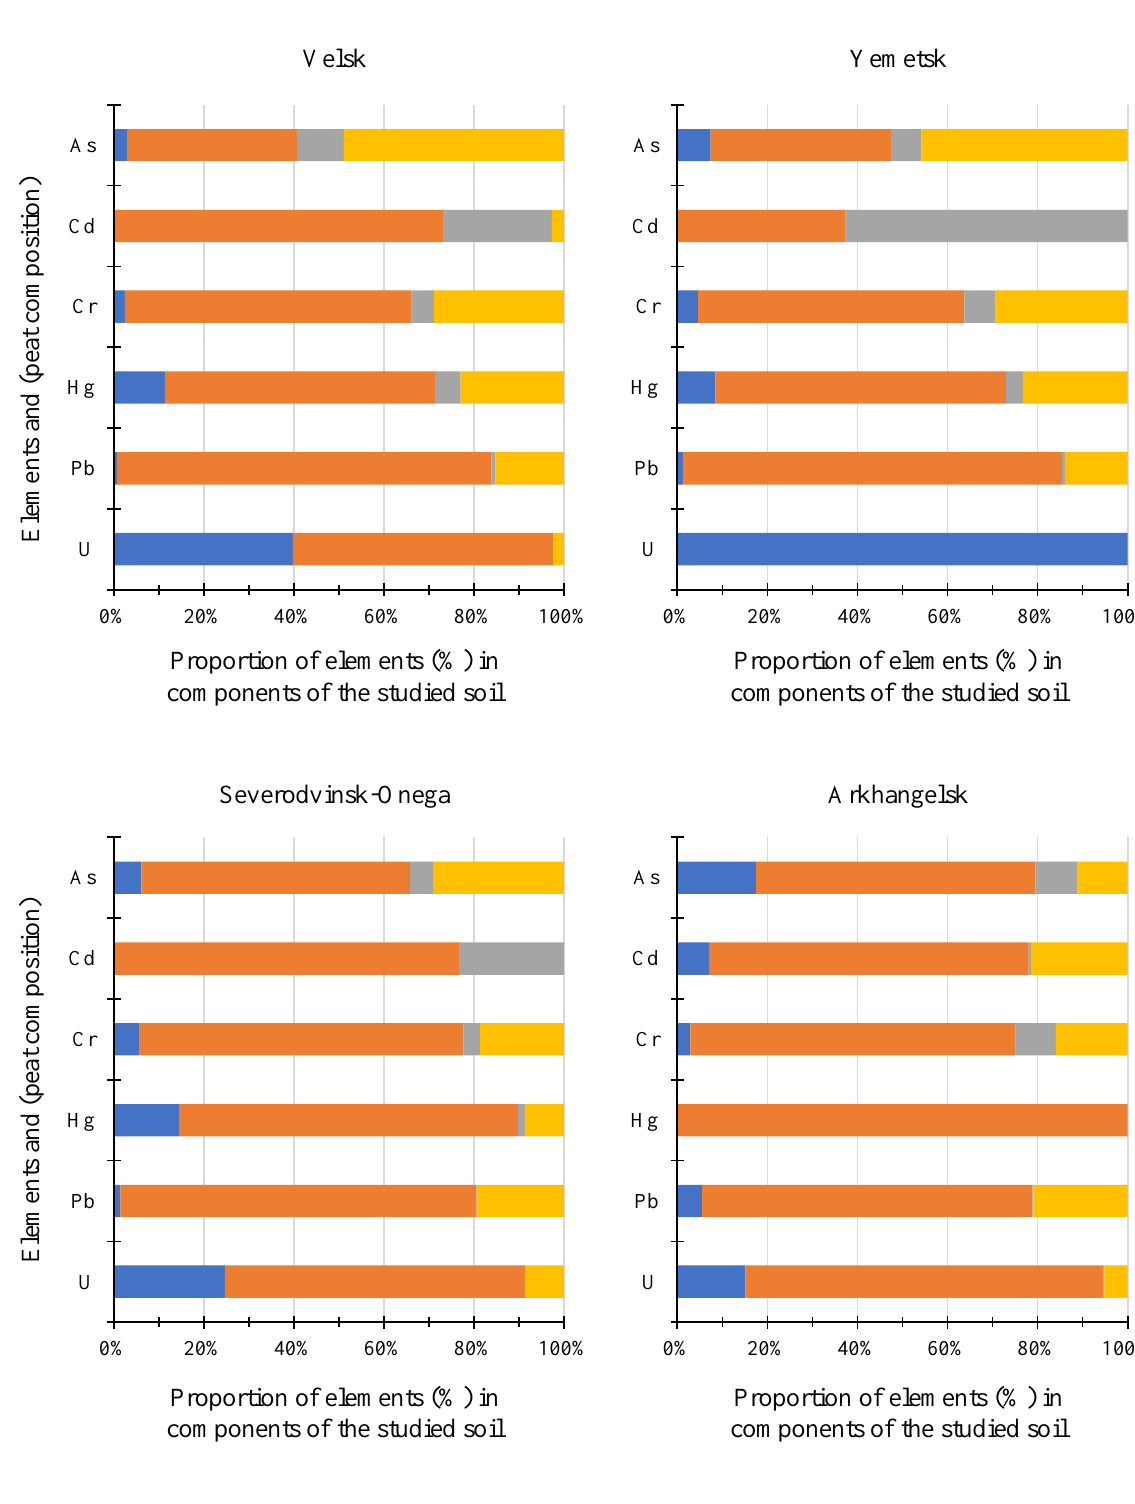
Figure 5. Distribution of elements between the components of peat at the four sampling locations: Velsk (top left); Yemetsk (top right); Severodvinsk-Onega (bottom left); and Arkhanelsk (bottom right). The components are, from left to right: humic acids (HA; blue), humin (orange), bitumen (grey) and fulvic acids (FA;